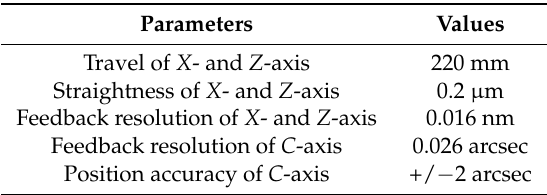
Table 1. Performance parameters of machine